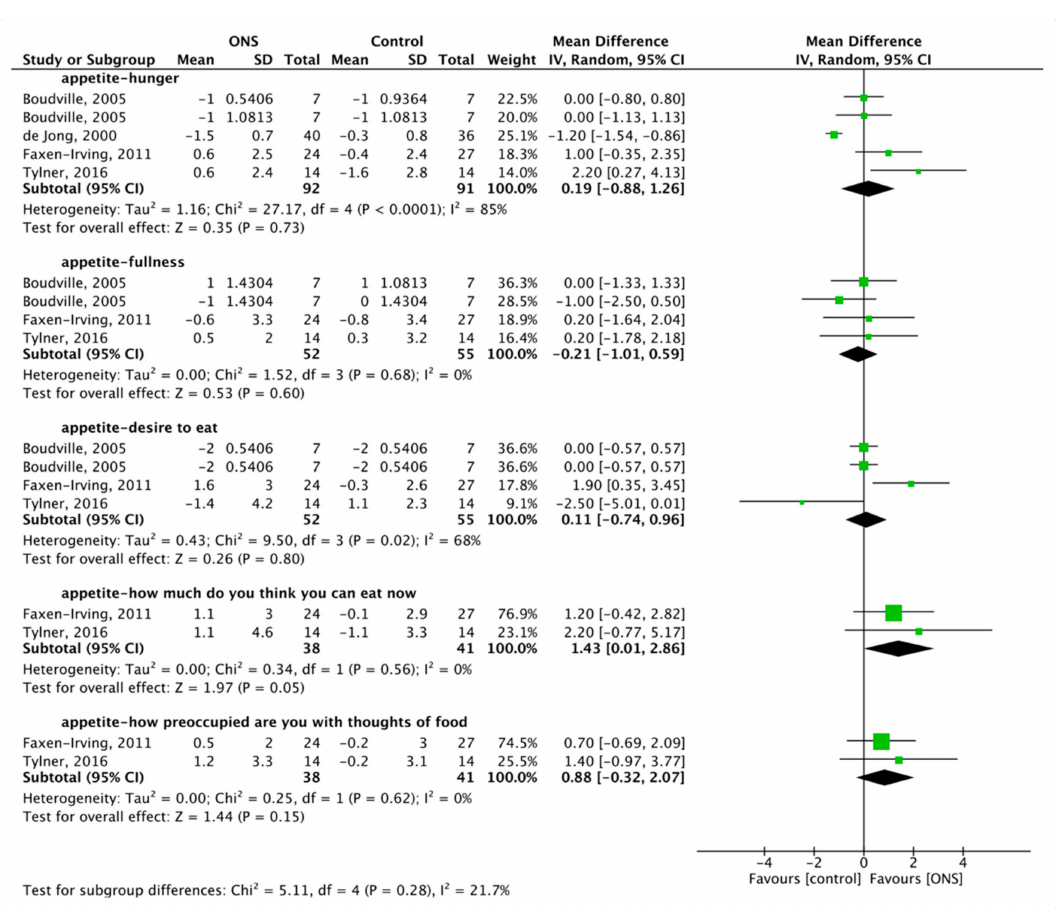
Figure 5. Forest plot comparing the effect of ONS on hunger, fullness, desire to eat, “how much do you think you can eat now?”, and “how preoccupied are you with thoughts of